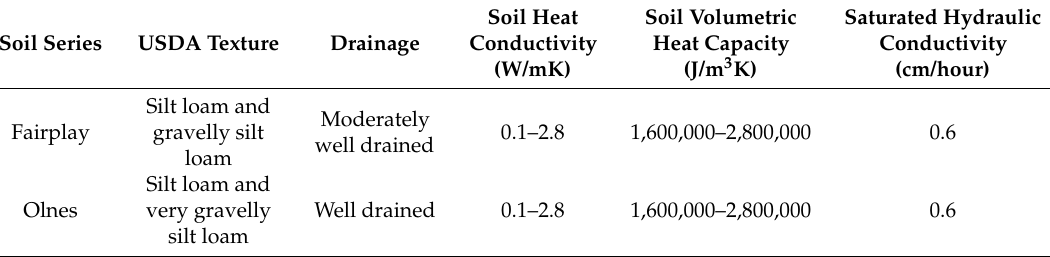
Figure 2. Land use and soil map of the study area: ( a ) soil type and ( b ) land use type. Table 1. Soil textural property of the study Table 1. Soil textural property of the study area.